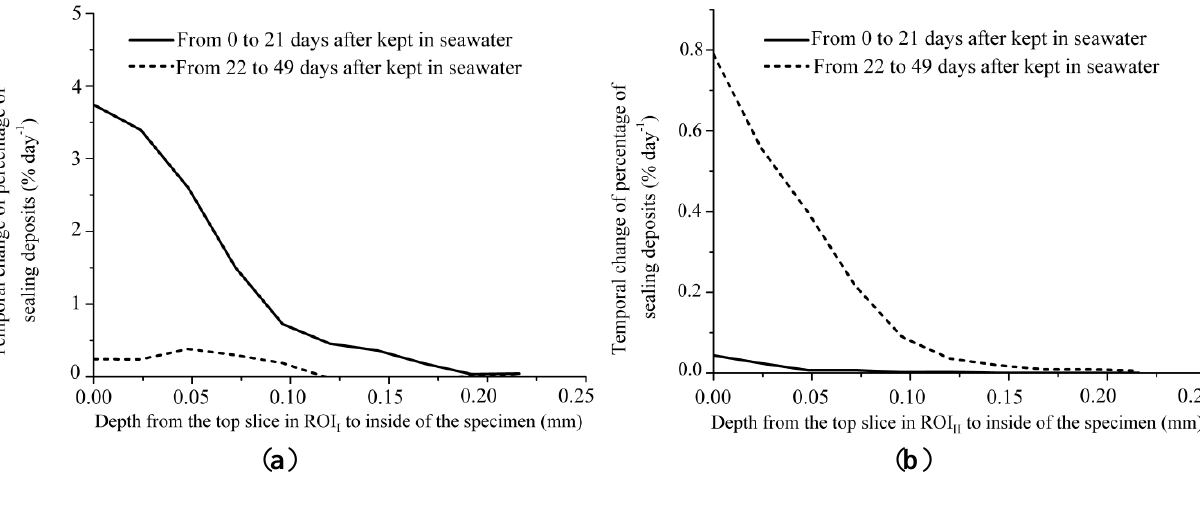
Figure 10. Temporal change of percentage of sealing deposits for specimen kept in seawater for 0–21 days and 22–49 days in ( a ) ROI